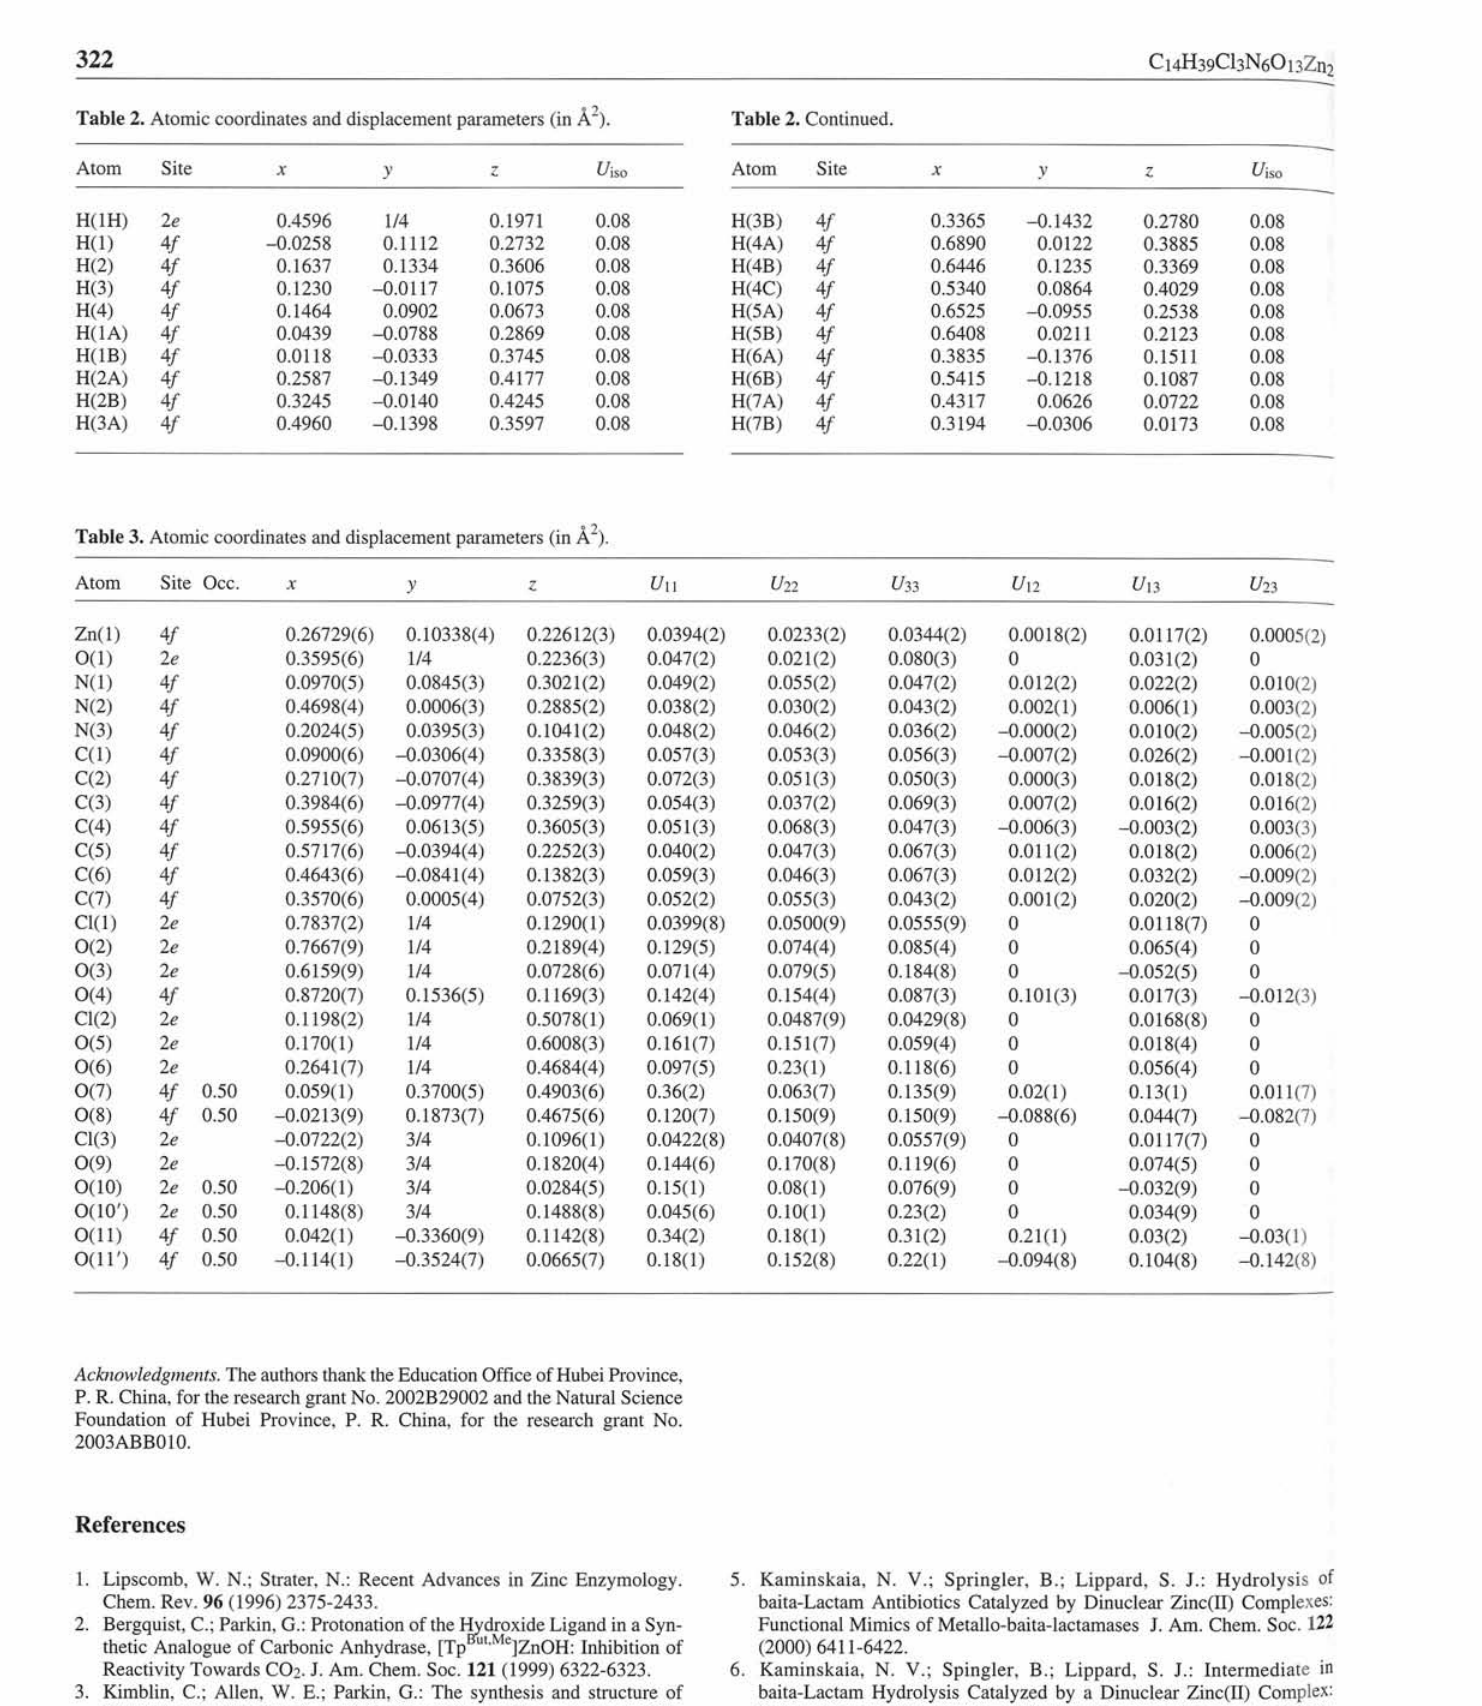
Table 2. Atomic coordinates and displacement parameters (in Á 2 ).